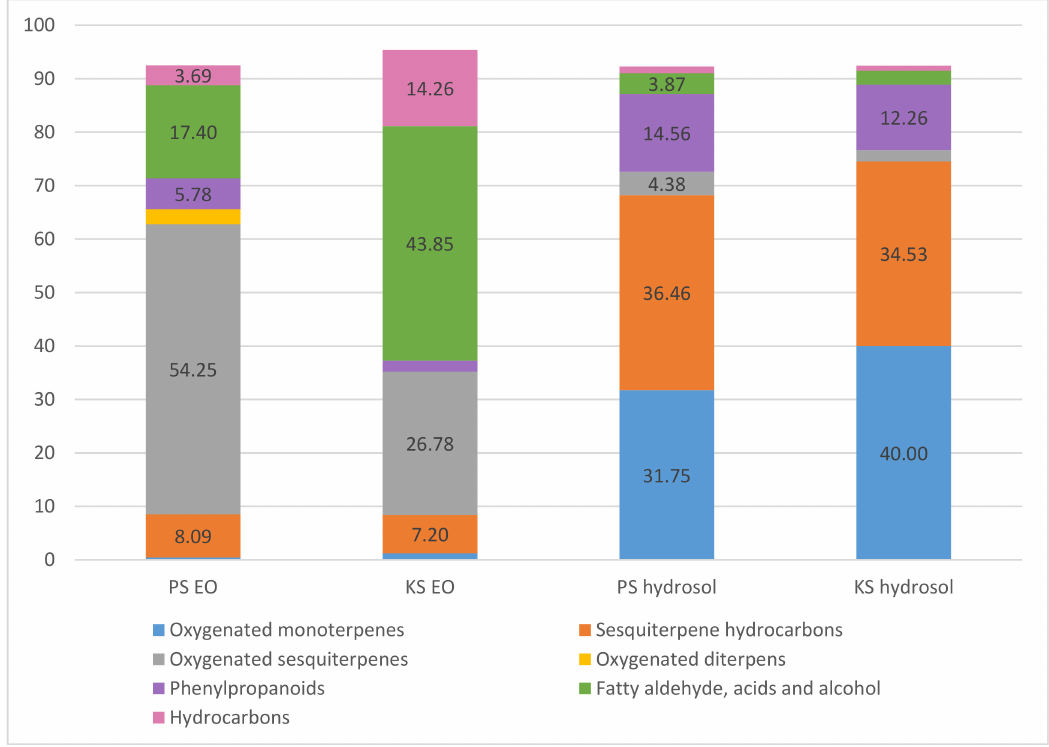
Figure 1. Distribution of volatile compounds by category in essential oils (%) and hydrosols (%); PS-Prenj sample, KS-Kamešnica